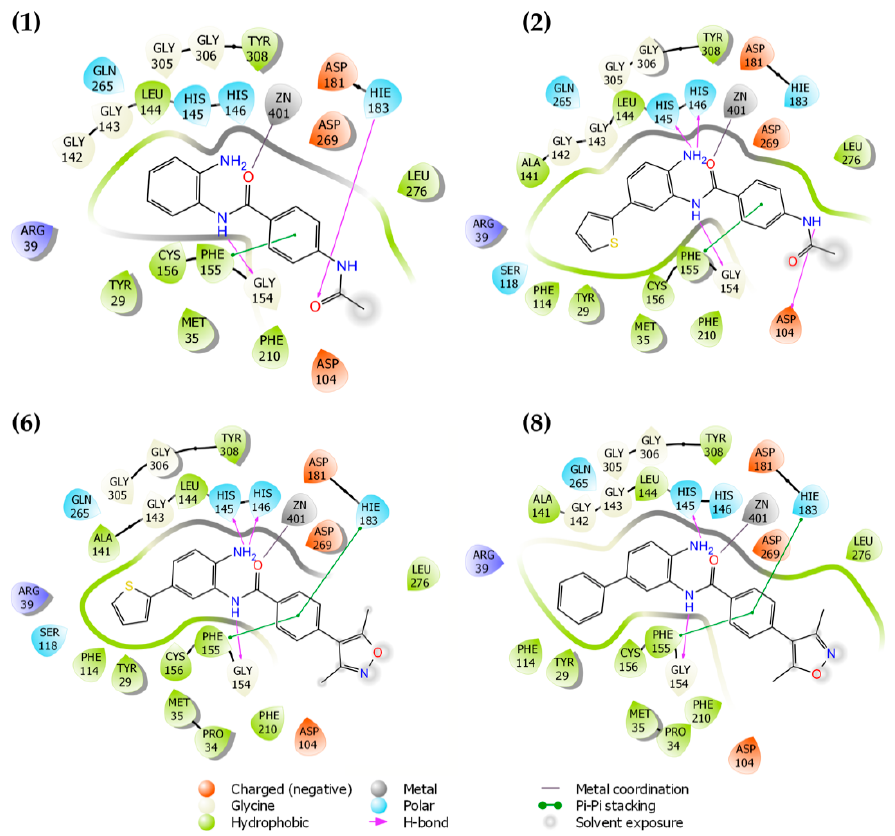
Figure 2. Two-dimensional (2D) representation of ligand interaction diagram for compounds 1 , 2 , 6 , and 8 docked on HDAC-2.